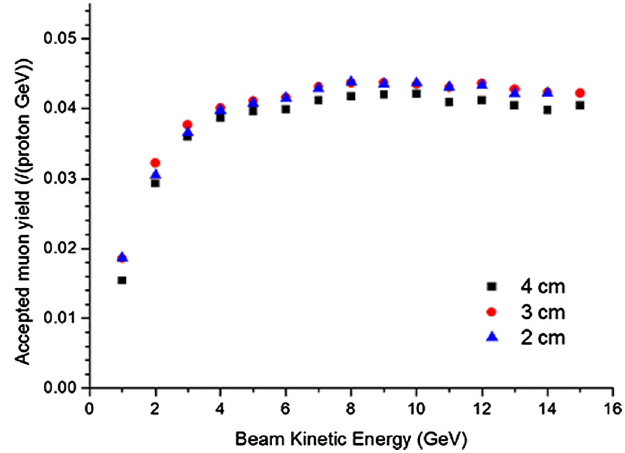
FIG. 11. Desired muons yields (per proton per GeV) for different jet widths for MOMENT as a function of beam energy.